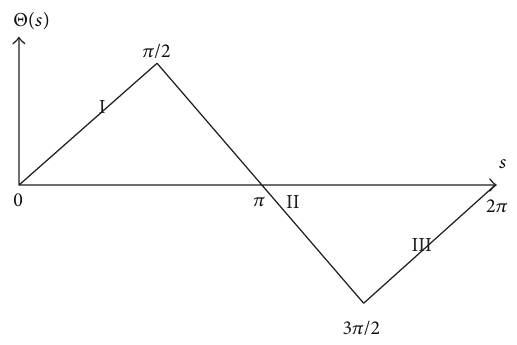
Figure 1: The 3-segment approximation to the periodic sine